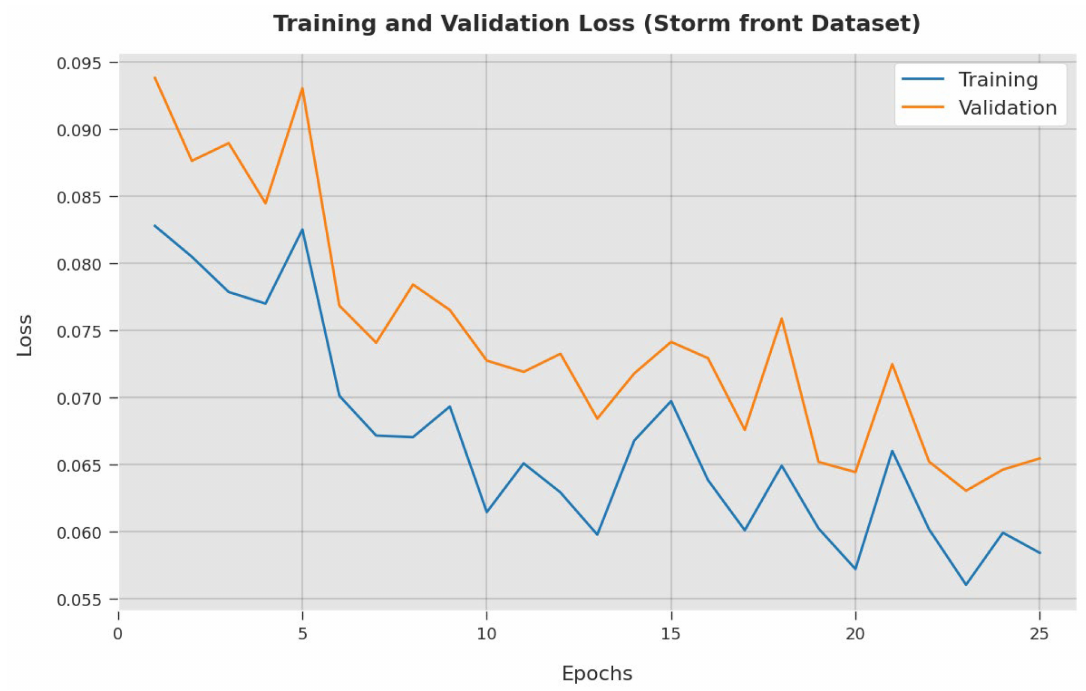
Figure 12. TL and VL analysis of ESGONLP-HSC algorithm under Storm front dataset. The TA and VA attained by the ESGONLP-HSC system on the Crowd-flower dataset are demonstrated in Figure 13. The experimental outcome implied that the